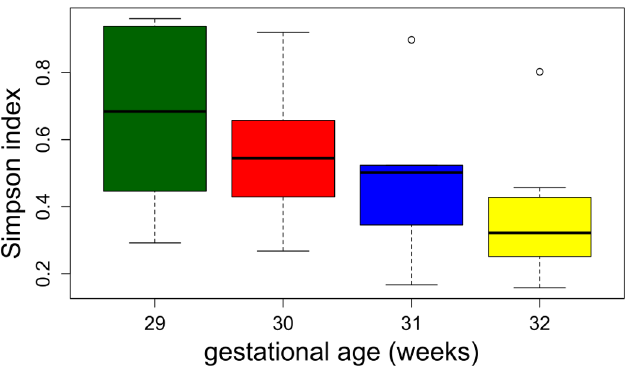
Fig 6. Boxplot of community α diversity at day 0 (prior to supplementation) according to the Simpson index and categorized according to gestational age at birth. Data are shown only for the weeks in which at least five infants were